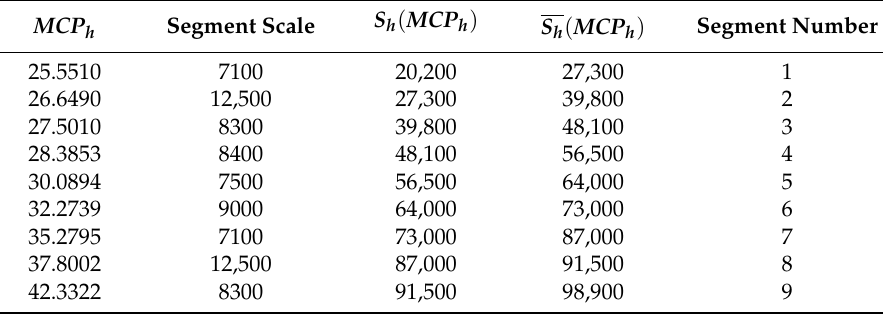
Table 2. Aggregated bidding curve/ MCP